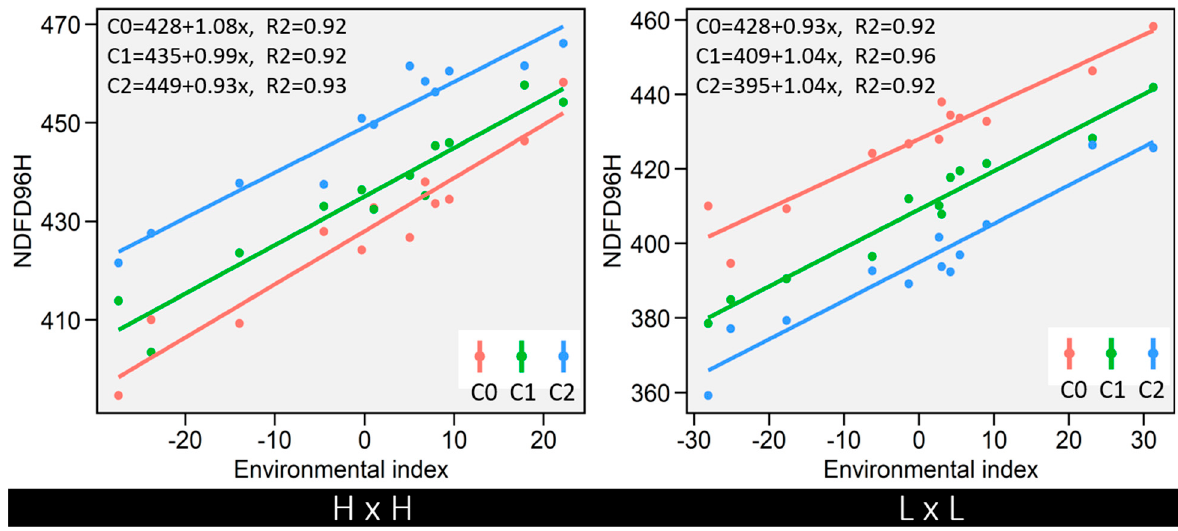
Figure 4. Environmental stability of 96 h IVNDFD with selection cycles across the 12 harvest environments. ( Left ) H × H, intermating of plants with high 16 h IVDFD and high 96 h IVNDFD. ( Right ) L × L, intermating of plants with low 16 h IVDFD and low 96 h IVNDFD.